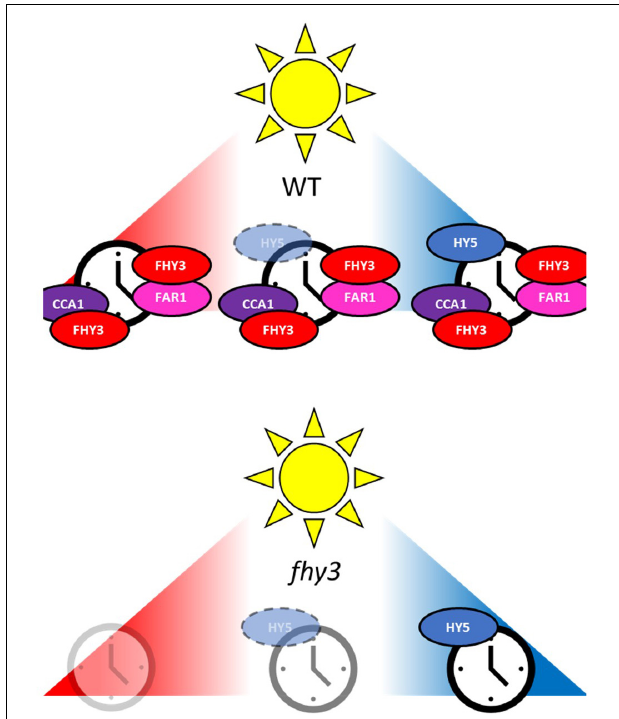
FIGURE 9 | Proposed model for the integration of red and blue light into to the plant clock via FHY3 and HY5. FHY3 plays a dual role in light input to the clock. Firstly, FHY3 acts in conjunction with FAR1 to form a transactivating complex targeting the fbs element in the promoter of CCA1 and ELF4 genes and is required for high amplitude of their expression (Li et al., 2011; Liu et al., 2020). Secondly, FHY3 but not FAR1 is required for the maintenance of wider overt rhythms in constant white and, particularly, red light, where loss of FHY3 causes severely disrupted rhythmicity. Our evidence suggests that this involves moderation of CCA1 activity. FHY3 but not FAR1 interacts with CCA1 and moderates it transcriptional activity in the clock (Li et al., 2011) and we show here that loss of FHY3 particularly disrupts CCA1 target genes. Our findings further suggest that the wavelength specificity of the fhy3 mutant phenotype in the maintenance of wider overt rhythms in constant light may reflect a conditional redundancy between FHY3 and HY5 in light input to the clock. We show here that genes most severely impacted in red light compared to white light are HY5 target genes. Levels and activity of HY5 decrease with decreasing ratio of blue to red light resulting in blue light-specific HY5 activity in light input to the clock (Hajdu et al., 2018). We propose that, in the absence of FHY3, HY5 compensates for FHY3 in maintaining rhythmicity in constant blue light. However, we propose that decreasing HY5 activity means that rhythmicity is disrupted in the fhy3 mutant in constant white and severely disrupted in constant red